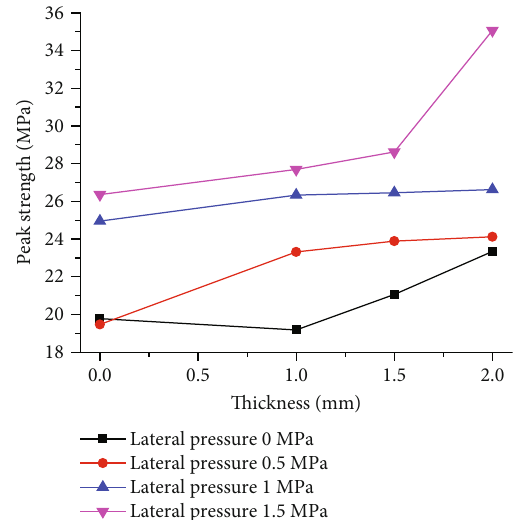
Figure 5: Comparison of peak strength of specimens reinforced with di ff erent thicknesses of aluminum alloy tube under the same pressure.